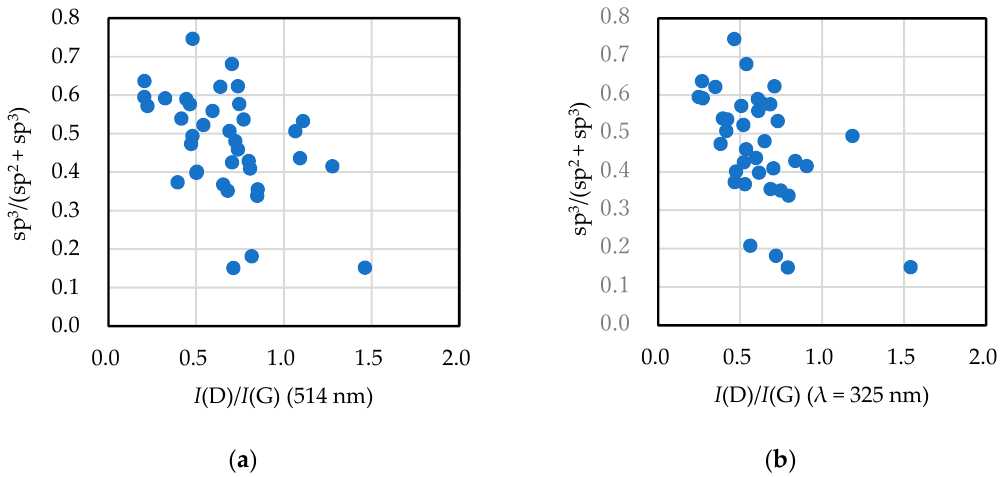
Figure 2. sp 3 ratio of amorphous carbon films vs. I (D)/ I (G) ratio of each film derived from ( a ) visible and ( b ) UV light Raman spectroscopic analyses.